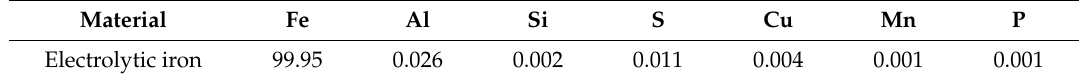
Table 2. The chemical composition of electrolytic iron (wt%).